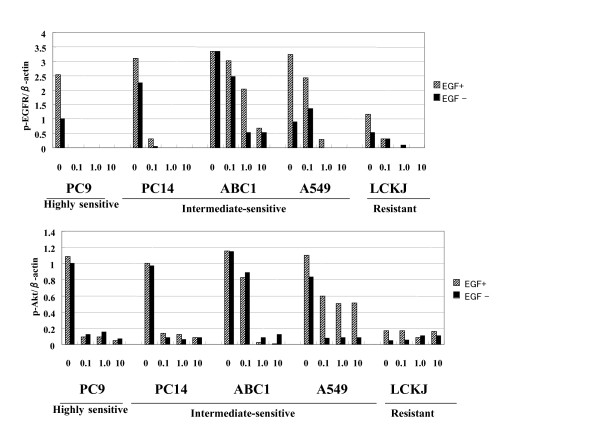
Summary of the effect of gefitinib on the molecules downstream of EGFR (Fig.7.). These images were quantified by measuring signal intensity using NIH Image (ImageJ1.32j).